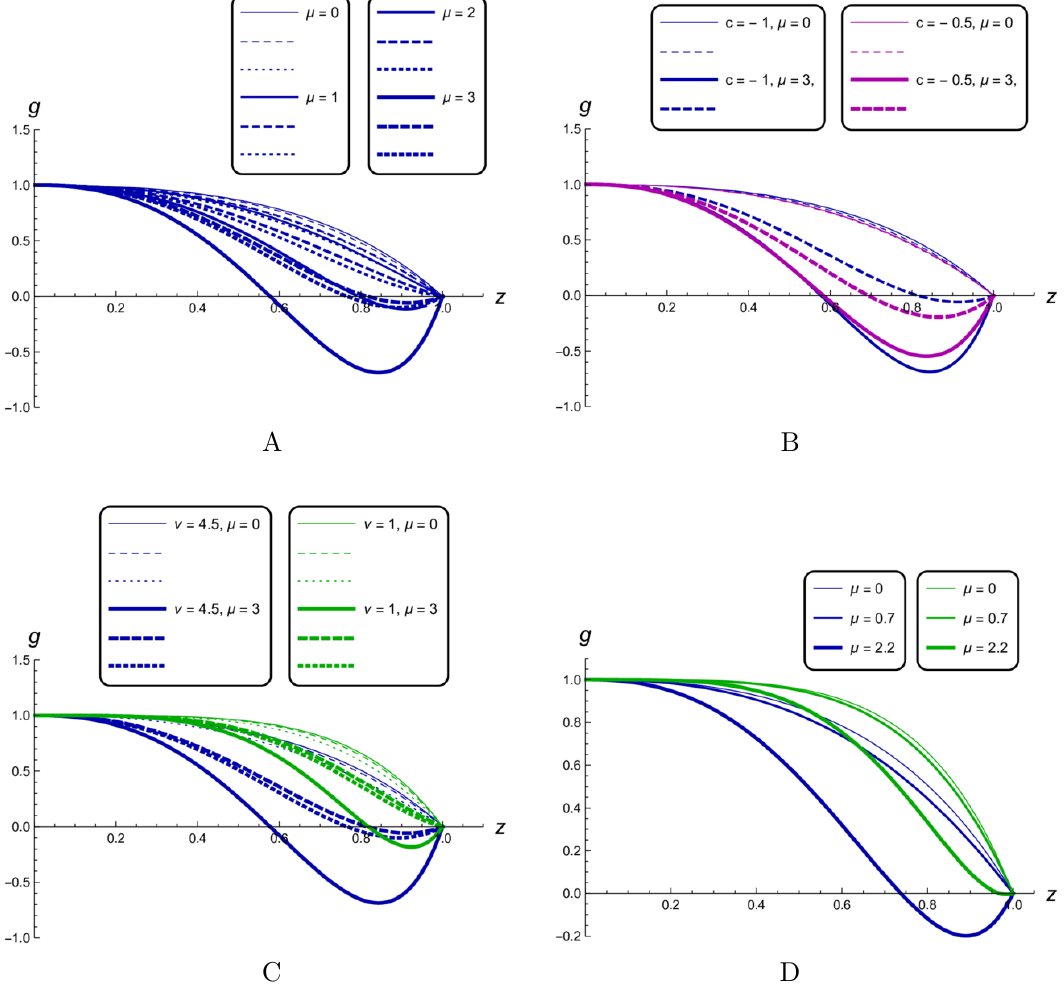
Figure 1 . Blackening functions g ( z ) (solid lines), g approx ( z ) (same thickness dashed lines) and g ( z ) (same thickness dotted lines) for z h = 1, (cid:23) = 4 : 5, c = (cid:0) 1 (blue lines), (cid:23) = 4 : 5, approx ; [2] c = (cid:0) 0 : 5 (magenta lines), (cid:23) = 1, c = (cid:0) 1 (green lines) and di(cid:11)erent (cid:22) = 0 ; : : : ;